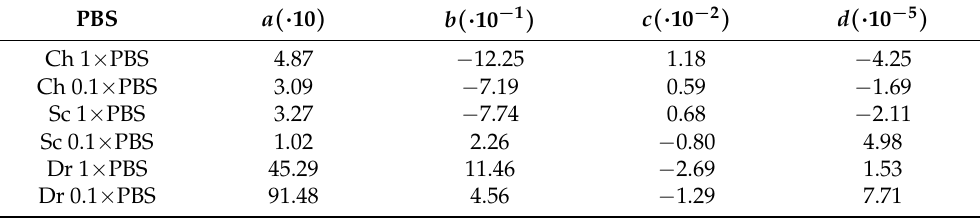
Figure A1. Device sensitivity as a function of the activation percentage. Ten random distributions following ( a ) channel-centered, ( b ) source-shifted and ( c ) drain-shifted cases are considered, fixing the configuration of activated receptors for each P value. Markers account for simulated data, while shaded areas depict σ S and lines correspond to (cid:104) S (cid:105) . Both 1 × PBS (blue) and 0.1 × PBS (red) concentra- tions were simulated. Results obtained for the uniform distribution are depicted by dashed lines. Table A1. Parameters of the fitting curves ζ = a + bP + cP 2 + dP 3 from Figure